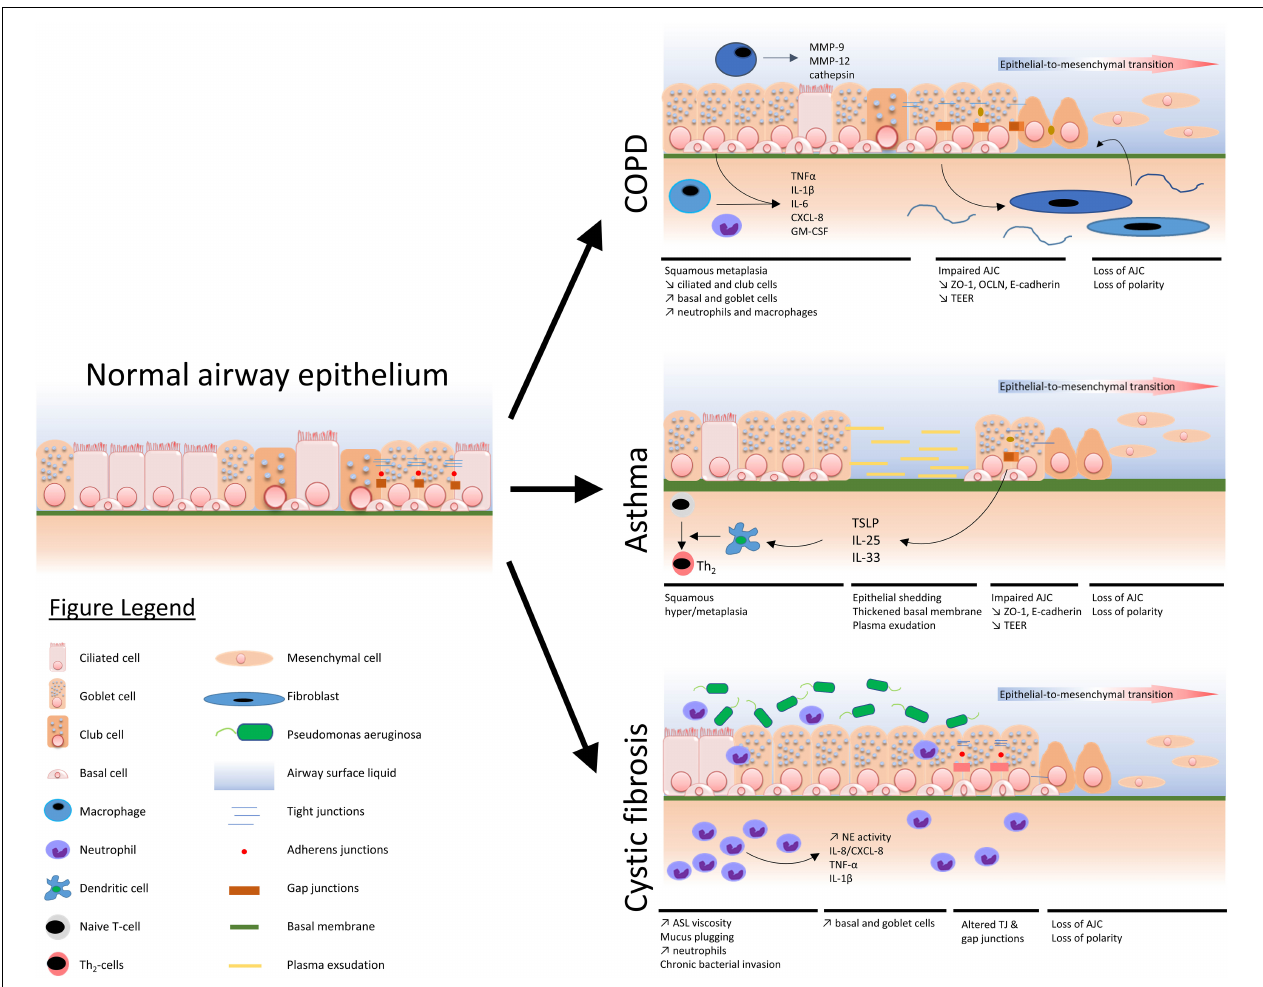
FIGURE 1 | Schematized view of main epithelial alterations observed in COPD, asthma, and cystic fibrosis as compared with a normal airway